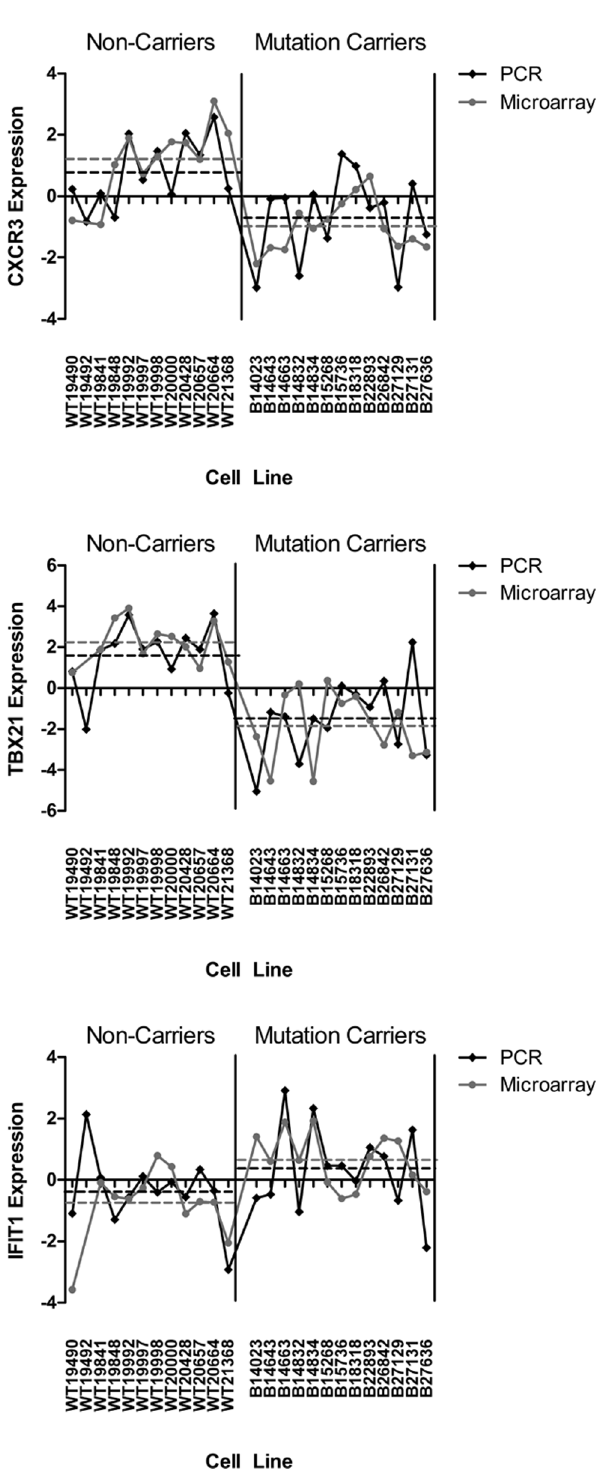
Figure 3. Comparison of qPCR and gene expression microarray results. Distribution of relative target expression levels between BRCA1 mutation carrier and non-carrier cell lines. Dashed lines represent mean relative expression values of each group (BRCA1 mutation carriers and non-carriers). Relative expression levels determined by microarray (black lines) and qRT-PCR (grey lines), for CXCR3, TBX21 and IFIT1.